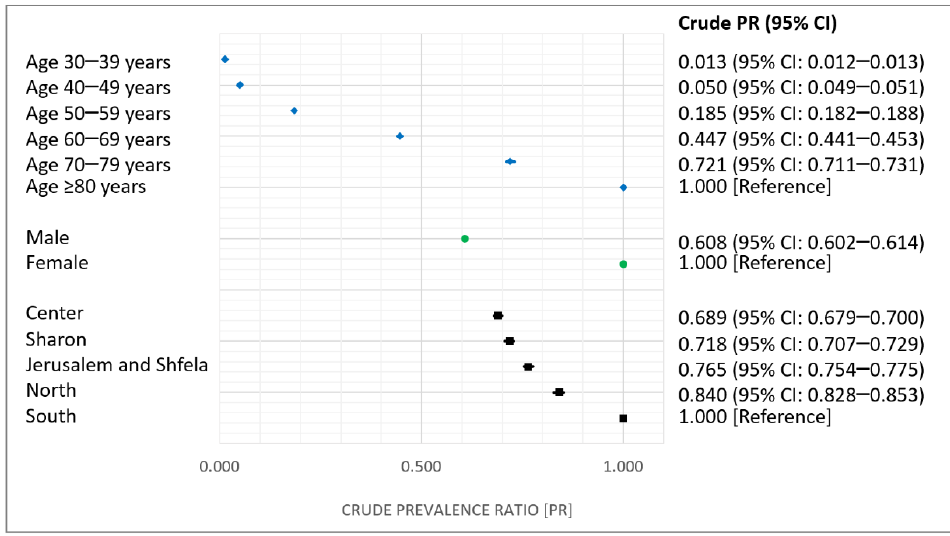
Figure 2. OA prevalence ratios in 2018, by age, sex, and district.